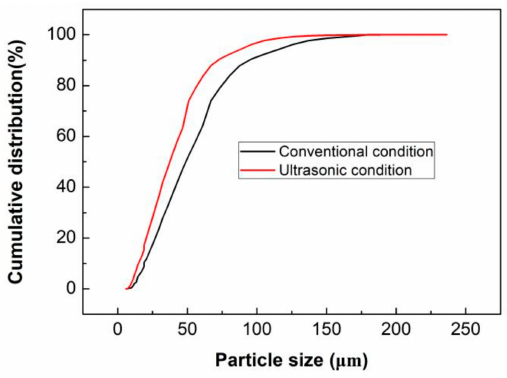
Figure 16. The particle size distribution of leached residue after conventional and ultrasonic